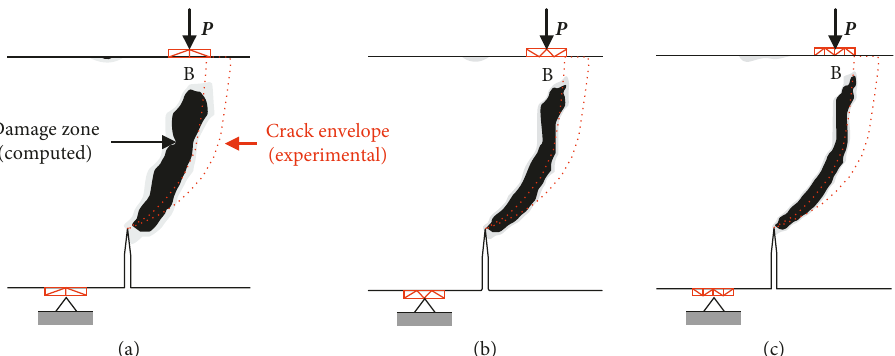
Figure 17: Final tensile damage profiles in the central part of the SEN concrete beam: (a) coarse mesh; (b) medium mesh; (c) fine mesh.